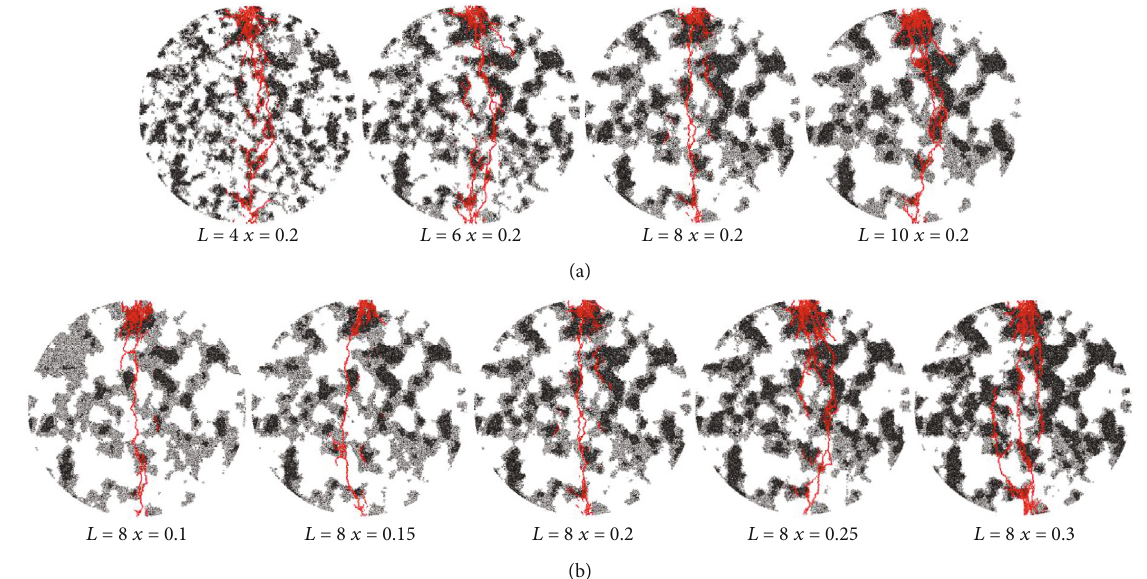
Figure 12: Brazil split test results with di ff erent structural parameters and component contents. (a) Fracture development diagram of specimens with di ff erent spatial correlation coe ffi cients. (b) Fracture development diagram of specimens with di ff erent component contents.